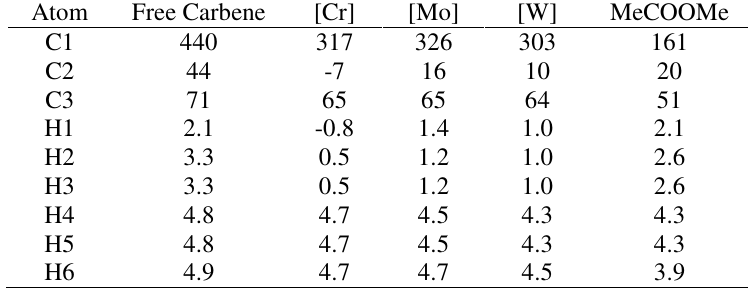
Table 5 . The 13 C- and 1 H-NMR chemical shifts (ppm).